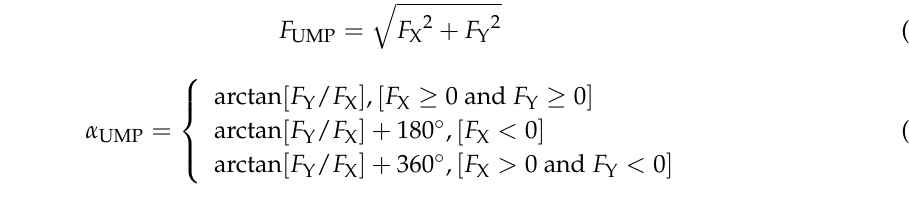
Dead slot Figure 6. Rotor lamination and field winding’s taps of A1552 model machine. Table 1. Parameters of A1552 non-salient pole model machine. Variable